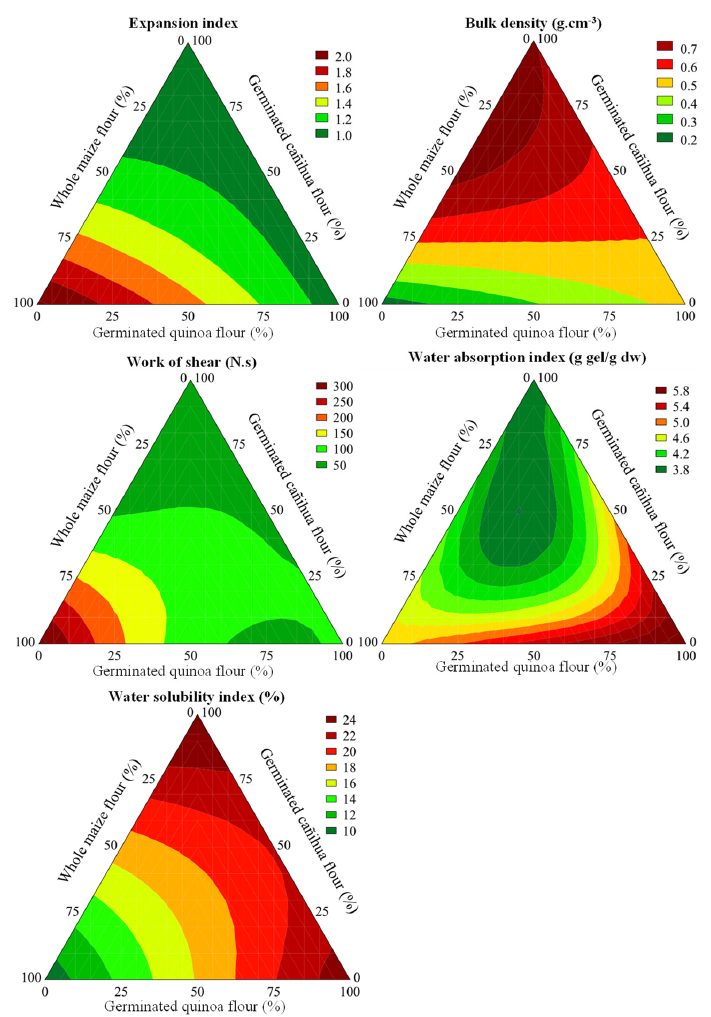
Figure 4. Contour plots of predicted expansion index, bulk density, shear work, water absorption index and water solubility index.